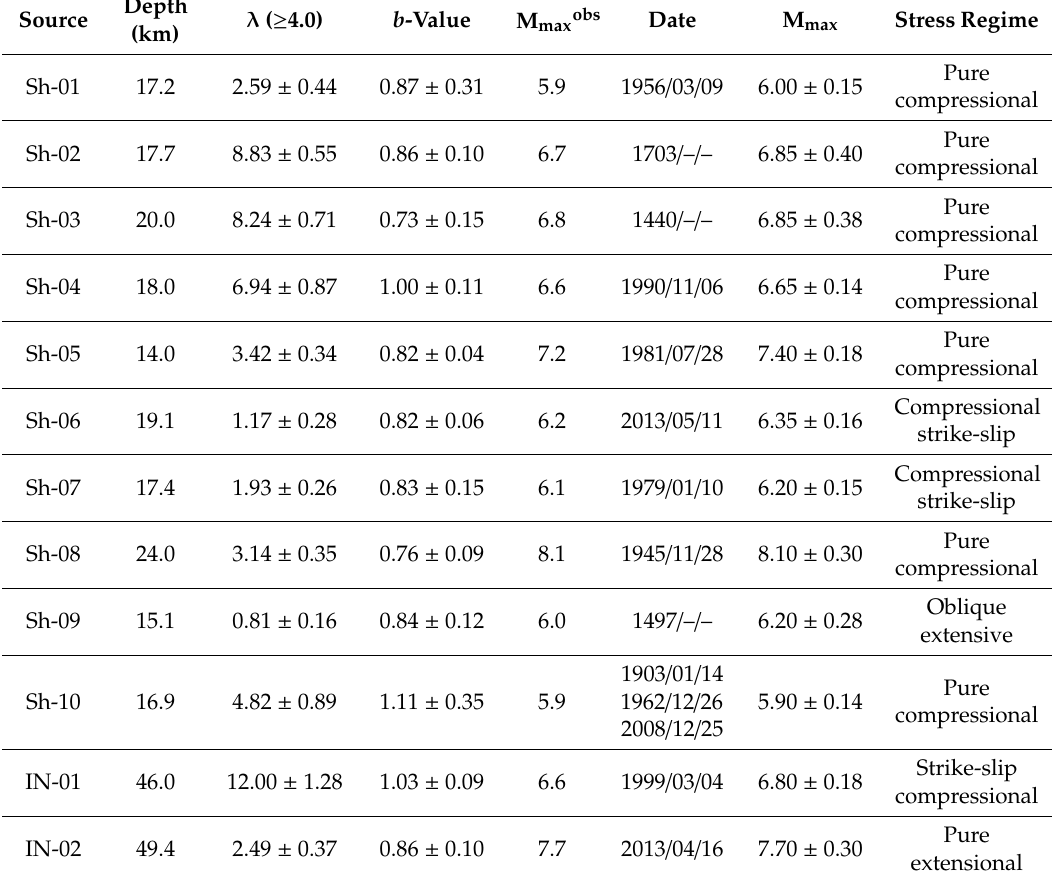
Table 3. Seismicity parameters (average depths, annual rate of earthquakes above Mw 4.0, b -value, maximum observed / recorded and maximum expected magnitudes) and stress regime for the model by Sawires et al.